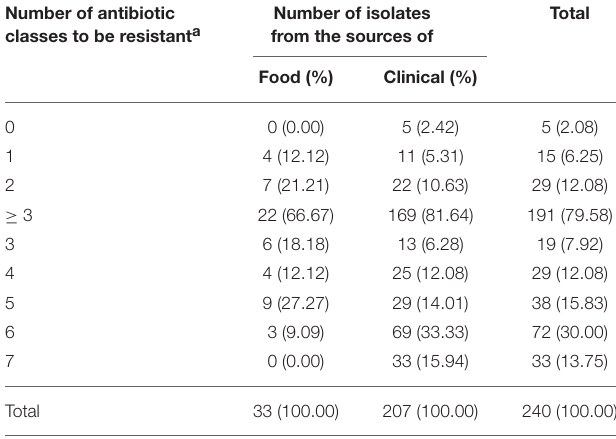
TABLE 3 | Resistance to multiple antibiotic classes of the 240 S. Typhimurium isolates. Number of antibiotic classes to be resistant a